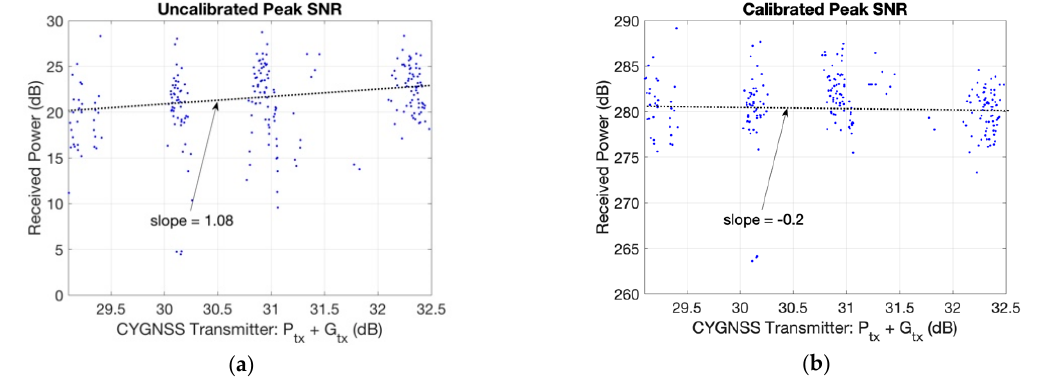
Figure 16. February 2018 SMAP-R samples as a function of the GPS transmitter information (P tx + G tx ) ( a ) uncalibrated data over a small area of the calibration target area (south-west corner) and ( b ) calibrated data over the same small area of the calibration target area. Note that calibrated values correspond to radar cross section values after applying calibration Equation (5), under coherent assumption. B.